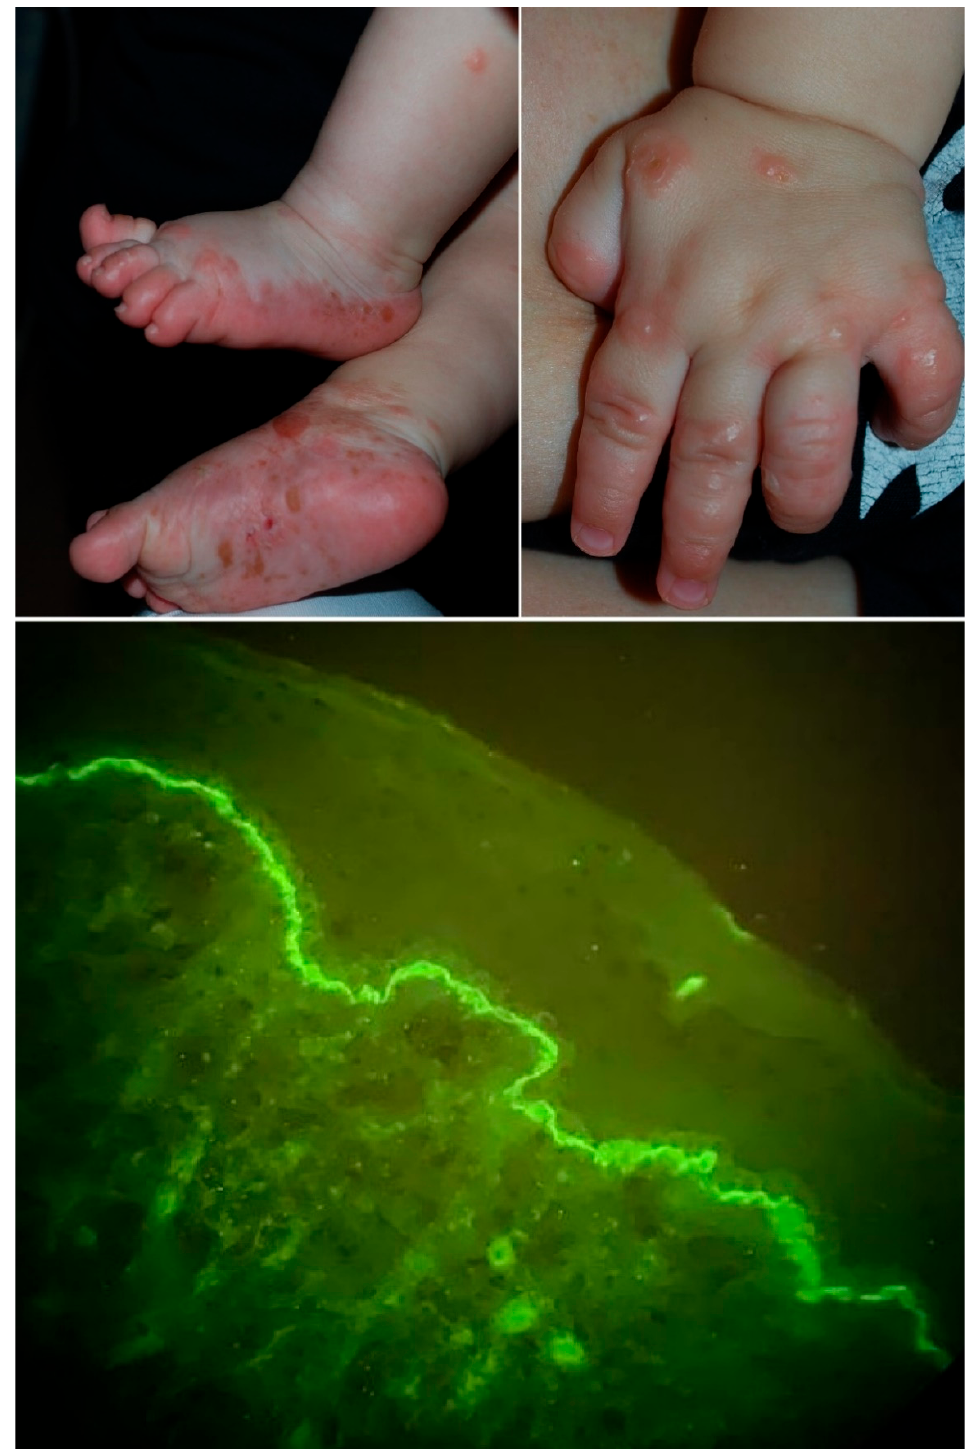
Figure 1. Bullae on the hands and feet. Direct immunofluorescence with linear deposition of im- munoglobulin G (IgG) at the dermo-epidermal